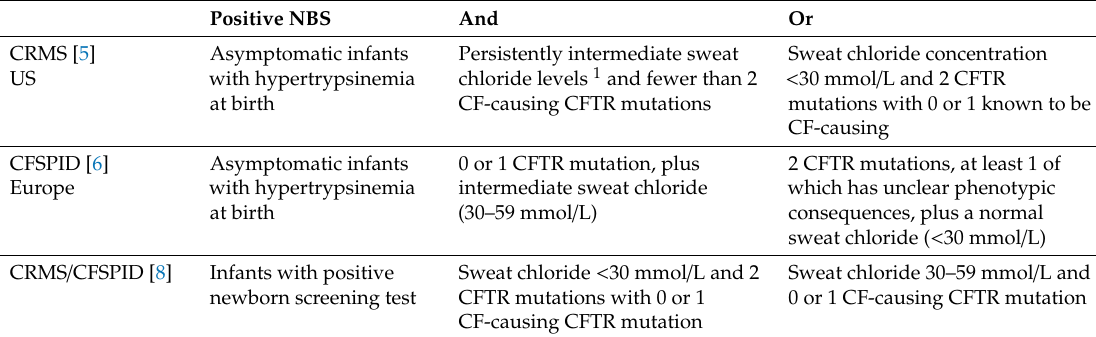
Table 1. Definitions for CF transmembrane conductance regulator-related metabolic syndrome (CRMS) and CF screen-positive, inconclusive diagnosis (CFSPID) and the harmonized definition CRMS / CFSPID.